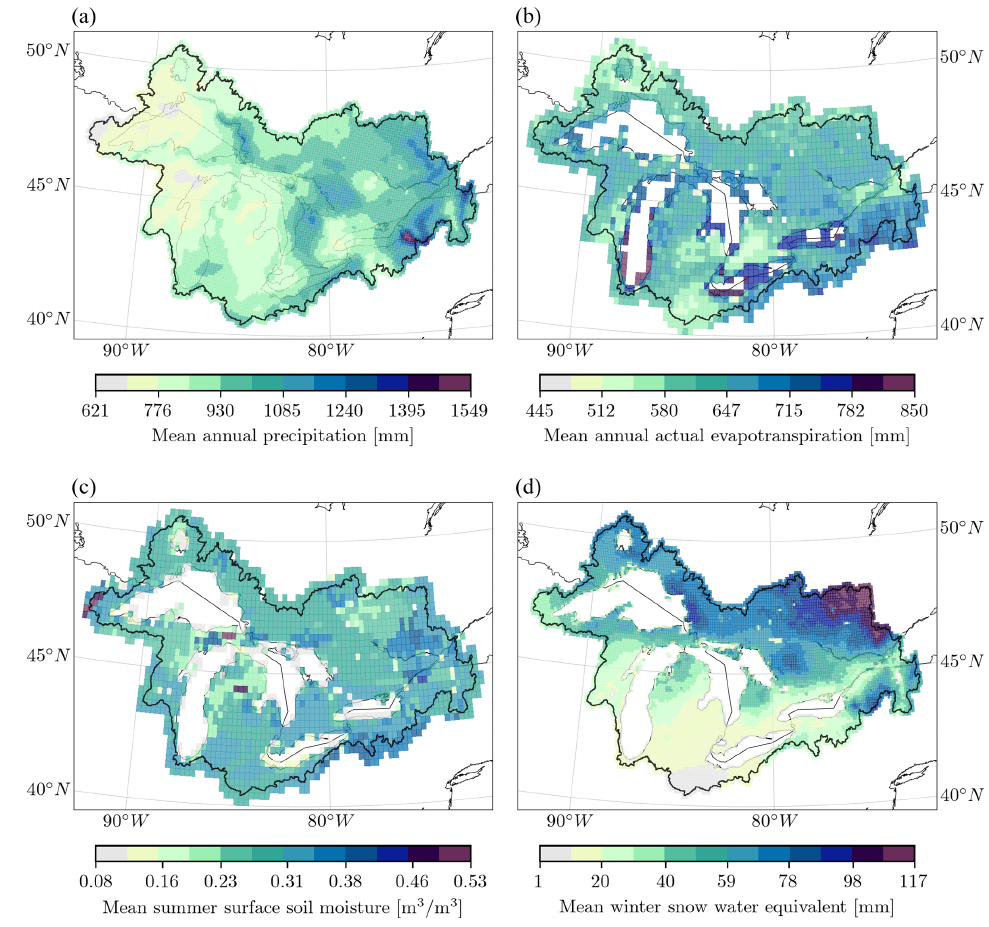
Figure 2. Meteorologic forcing data and auxiliary datasets. (a) The meteorologic forcings are provided by the Regional Deterministic Reanalysis System v2 (RDRS-v2; 10km; hourly; Gasset et al., 2021). The figure shows the mean annual precipitation derived for the 18 years during which the dataset is available and used in this study (2000–2017). The forcing inputs are preprocessed as needed by the models, e.g., aggregated to basin averages or aggregated to daily values. (b) Actual evapotranspiration estimates and (c) surface soil moisture from the Global Land Evaporation Amsterdam Model (GLEAM v3.5b; 25km; daily; Martens et al., 2017) and (d) snow water equivalent estimates from the ERA5-Land dataset (Muñoz Sabater, 2019; 10km; daily) have been used to evaluate the calibrated model setups. All datasets have been cropped to the study domain (black line). The actual evapotranspiration and surface soil moisture ( panels b and d) are not available over the lake area (missing grid cells). Panels (b–d) show the mean annual estimates for the auxiliary variables. The average soil moisture ( panel c) is based on summer time steps only (June to October), while for the snow water equivalent annual mean only values larger than 1mm of daily snow water equivalent were considered. In both cases, this is what was considered to evaluate model performance regarding these